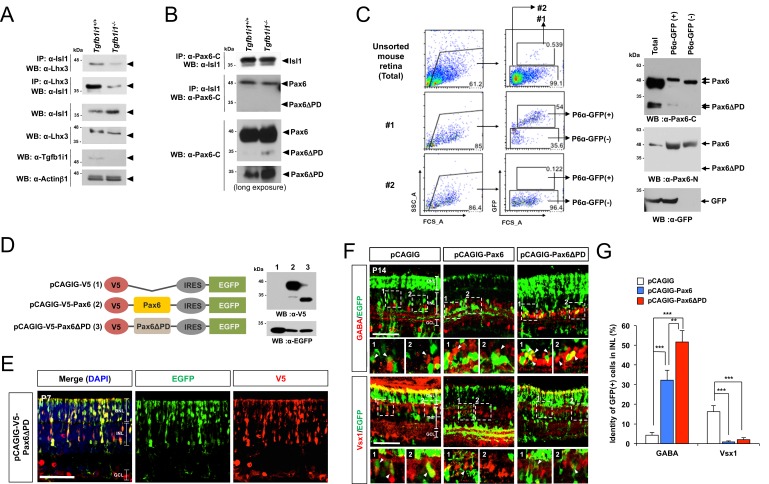
Pax6 α-enhancer-induced Pax6ΔPD isoform supports GABAergic amacrine cell fate.(A) Reciprocal co-IP and WB analyses with the indicated antibodies reveal a reduced interaction between Isl1 and Lhx3 in P7 Tgfb1i1−/−mouse retinas compared with littermate Tgfb1i1+/+retinas (top two WB images). Tgfb1i1−/−retinal lysates show 1.6-fold higher Isl1 level than Tgfb1i1+/+retinal lysates and no significant change in the levels of Lhx3 and Actinβ1 (bottom four WB images). (B) No significant difference in the assembly of Isl1 and Pax6 was observed in P7 Tgfb1i1+/+and Tgfb1i1−/−littermate mouse retinas (top two WB images). Tgfb1i1−/− retinas show higher expression of the Pax6ΔPD isoform than Tgfb1i1+/+retinas and no change in full-length Pax6 (bottom two WB images). (C) Pax6 α-enhancer-active cells were isolated from P14 P6α-CreiGFP retinas by repeated FACS (see the Materials and Methods). Lysates of GFP(+) and GFP(-) retinal cells were then analyzed by SDS-PAGE and WB with a rabbit anti-Pax6 antibody. Successful purification of the cells was confirmed by WB detection of GFP in each fraction. (D) Diagram of pCAGIG DNA constructs encoding V5-tagged Pax6 (pCAGIG-V5-Pax6) and Pax6ΔPD (pCAGIG-V5-Pax6ΔPD). These constructs express EGFP from an IRES linked to the V5-Pax6 or V5-Pax6ΔPD cDNAs. This allowed for the confirmation of successful expression of the cDNAs in in P7 mouse retinas electroporated with the indicated pCAGIG DNA constructs at P0 by WB detection of EGFP and V5. (E) Co-expression of V5-Pax6ΔPD and EGFP in P7 mouse retinas was also determined by immunostaining with mouse anti-V5 (red) and chick anti-GFP (green) antibodies. (F) The identities of EGFP-positive retinal cells co-expressing Pax6 or Pax6ΔPD in P14 mouse retinas were determined by staining with antibodies against various amacrine and bipolar cell-specific proteins. The images are mouse retinal sections stained with anti-GABA (top) and anti-Vsx1 (bottom) antibodies. Arrowheads indicate cells positive to both of EGFP and the markers. Additional immunostaining results are provided in Figure 5—figure supplement 2. (G) EGFP-positive cells co-expressing each cell type-specific marker are shown as a percentage of total EGFP-positive INL cells. Values on the Y-axis are averages. Error bars indicate STD (n = 5); **p<0.01; ***p<0.001.